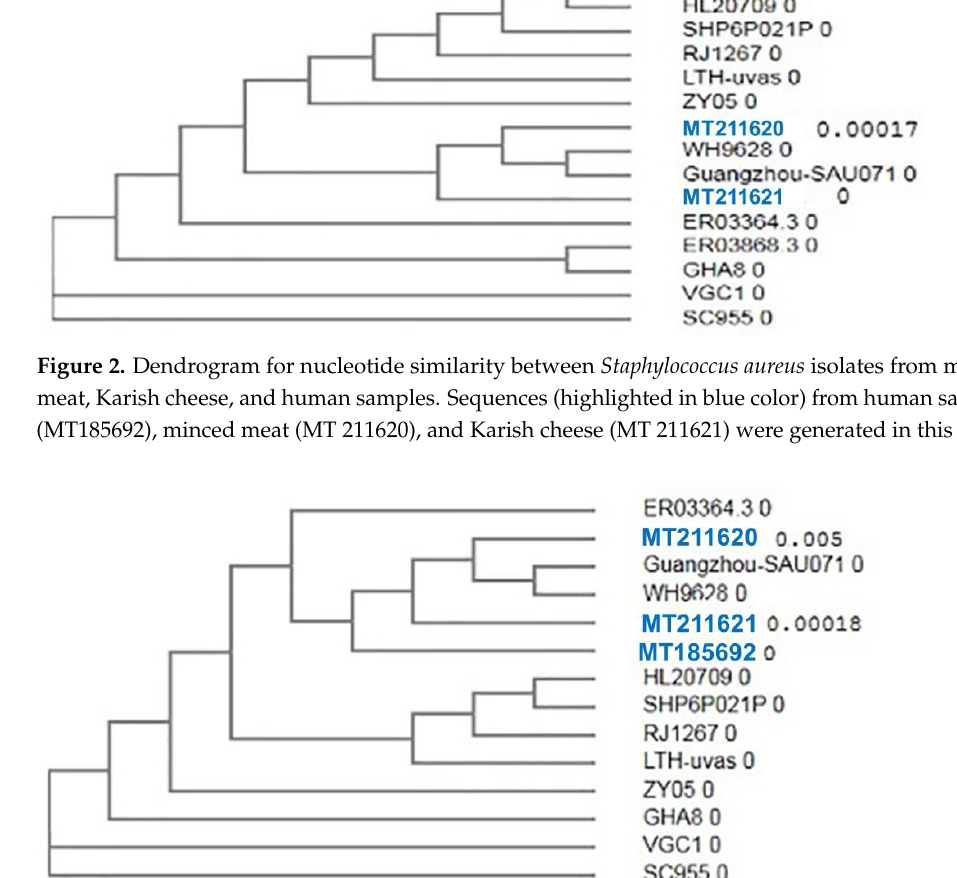
Figure 3. Dendrogram for protein similarity between Staphylococcus aureus isolates from minced meat, Karish cheese, and human samples. Sequences (highlighted in blue color) from human samples (MT185692), minced meat (MT 211620), and Karish cheese (MT 211621) were generated in this study.